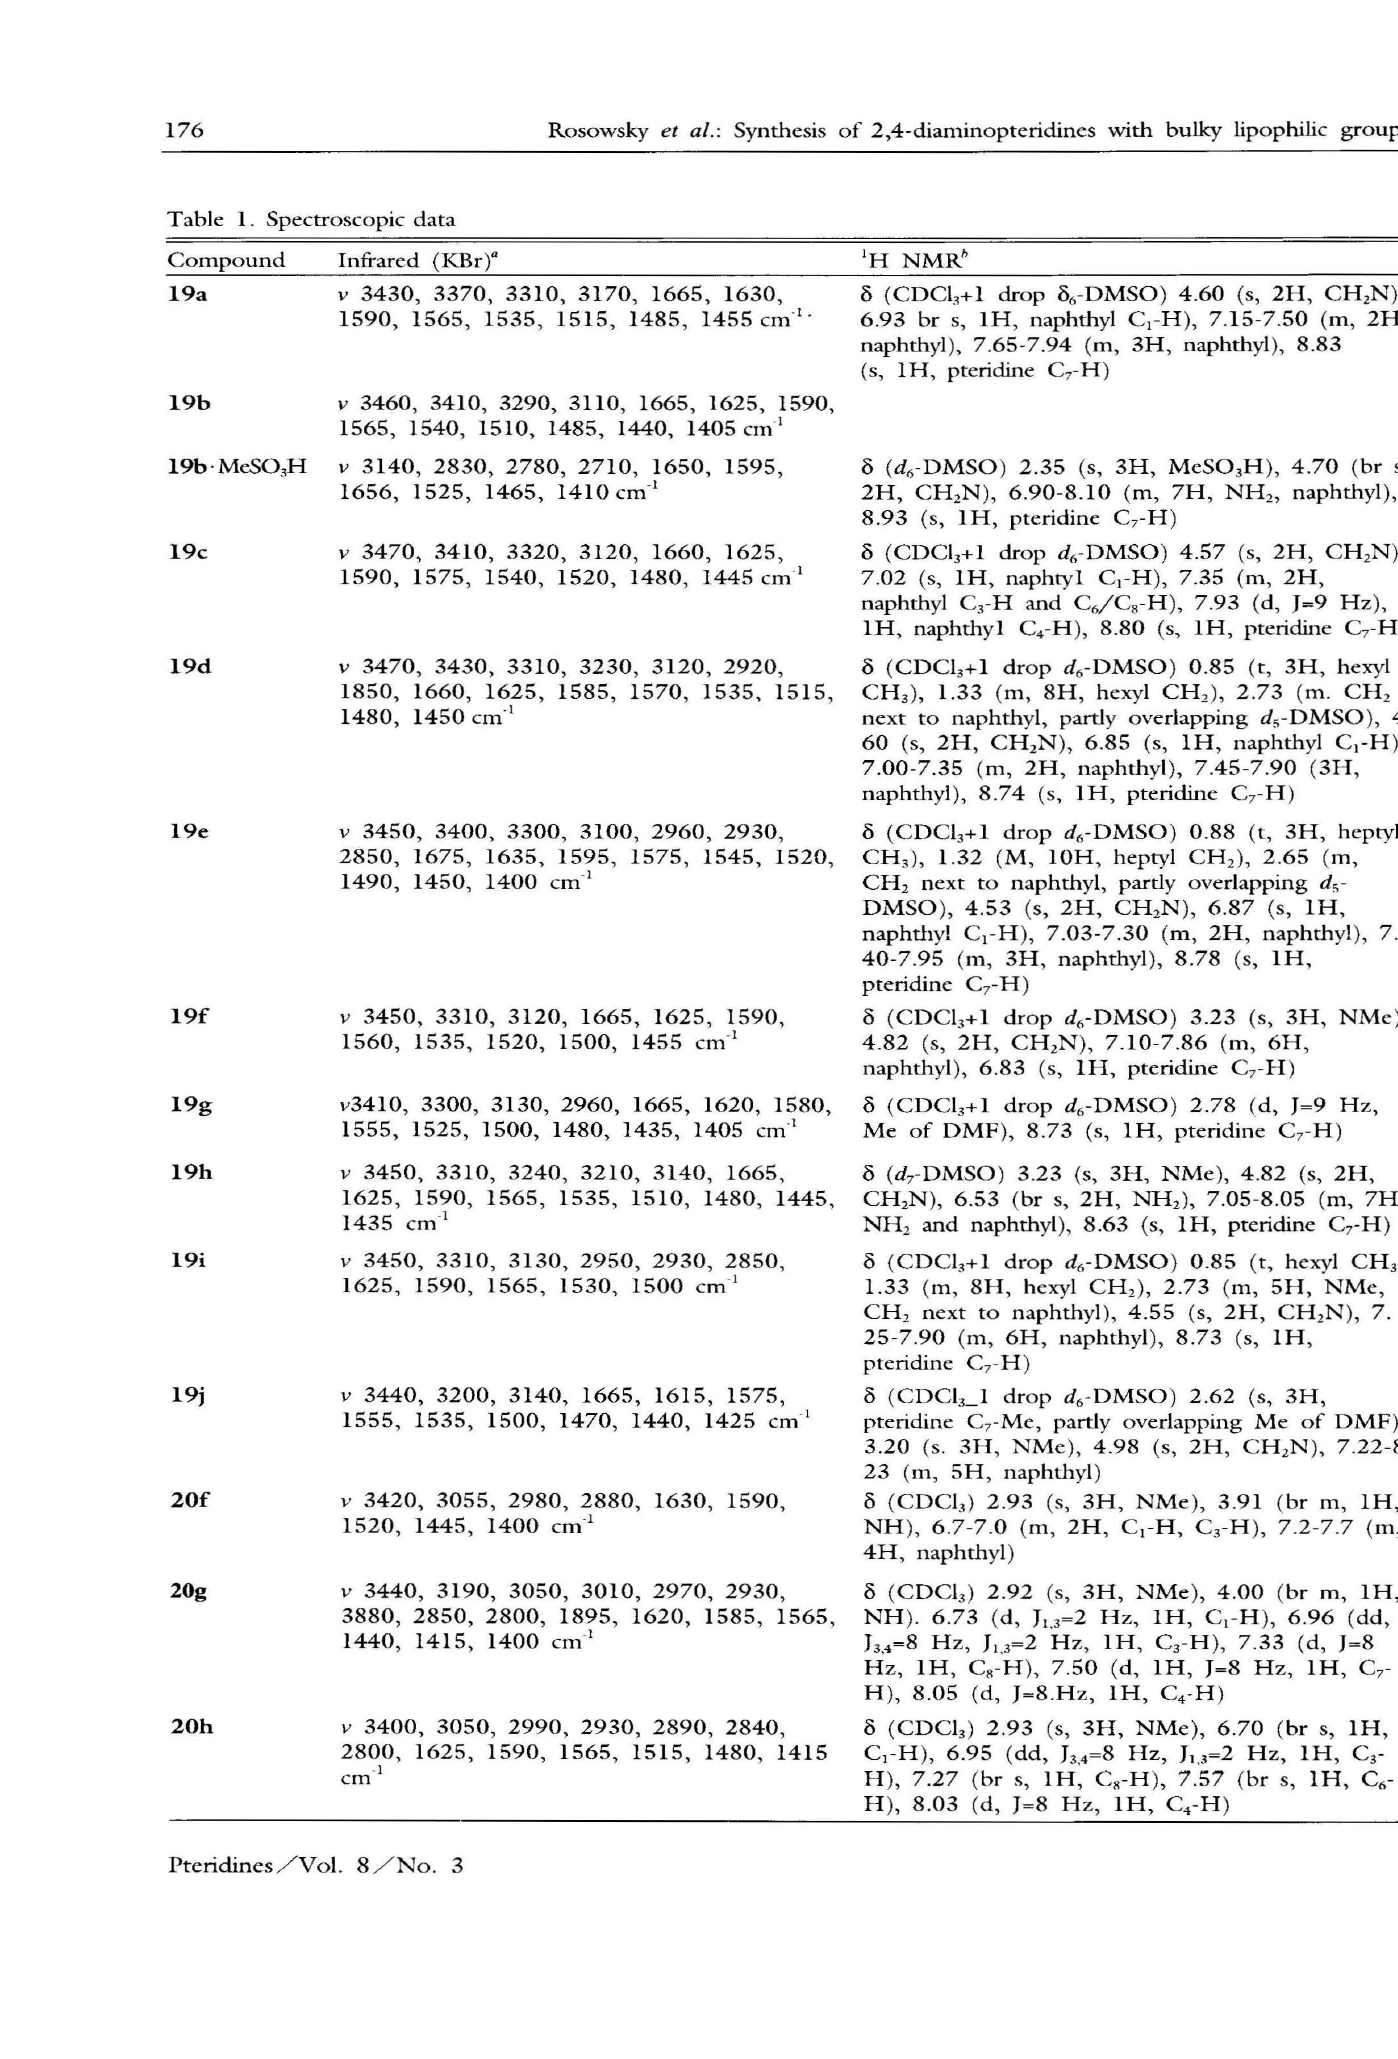
Table 1. Spectroscopic data